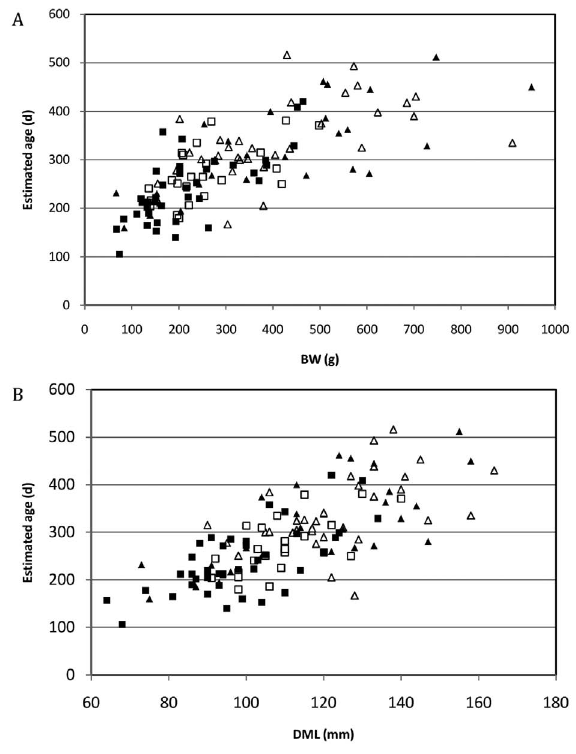
Fig. 4. – Scatterplots showing estimated age (d) of each Eledone cirrhosa specimen versus BW in grams (A) and DML in millime- tres (B). Full squares, west coast males (n=39); open squares, north coast males (n=23), full triangles, west coast females (n=27); and open triangles, north coast females (n=33).